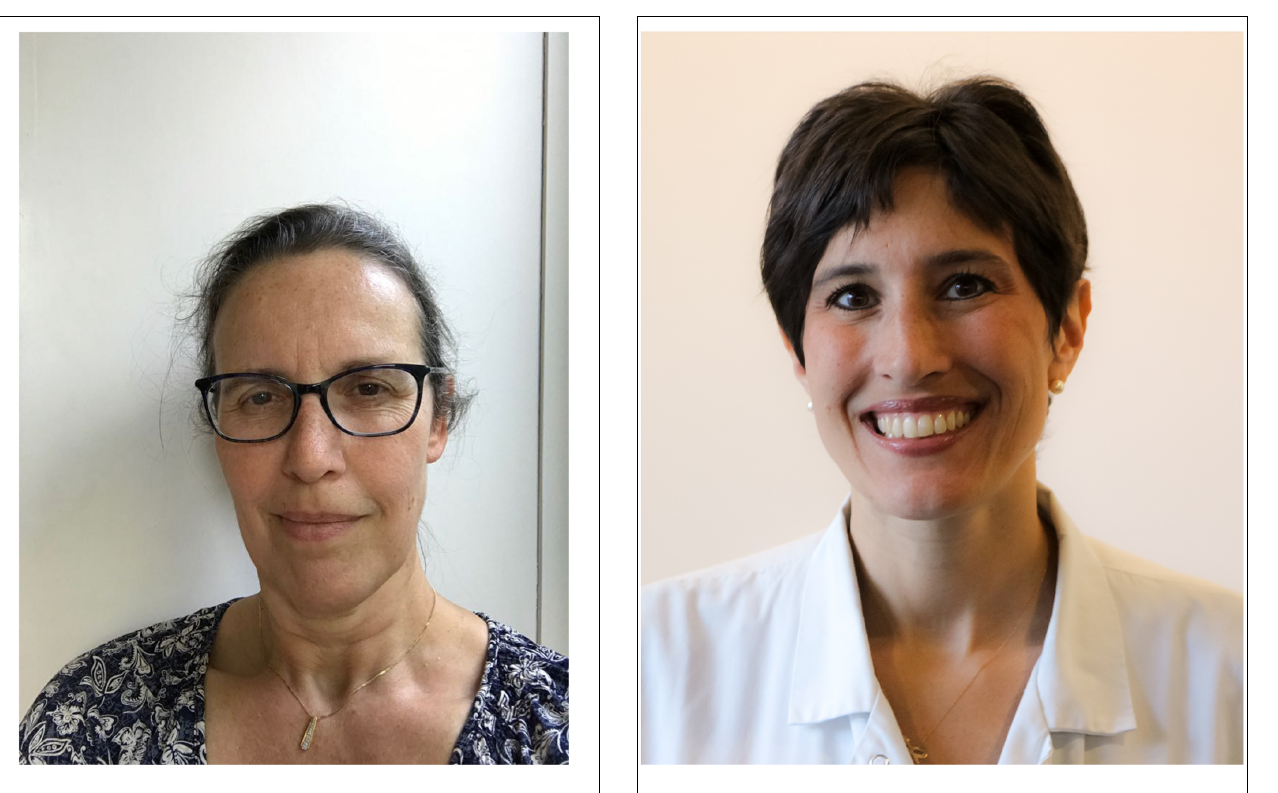
FIGURE 6 | Patricia Limousin, provided by Patricia Limousin. FIGURE 7 | Carine Karachi, provided by Carine